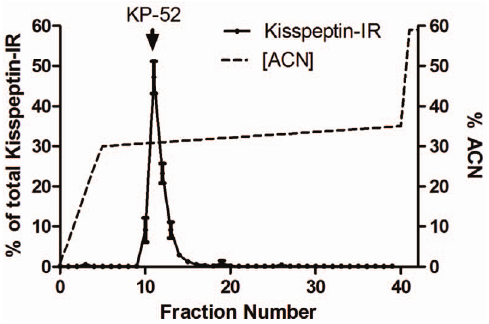
Figure 2. Parallelism of standard and tissue extract for novel rodent Kisspeptin RIA. Kisspeptin 2 10 (KP-10) and hypothalamus (Hypo) ( n =5).